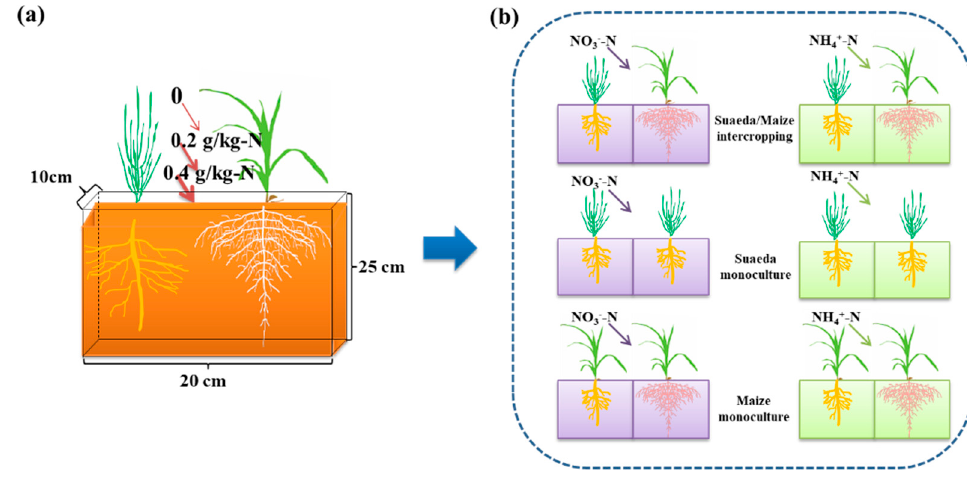
Figure 7. Experimental schematic diagram. ( a ) Experimental device. ( b ) Experimental procedure in the different cropping patterns. the different cropping